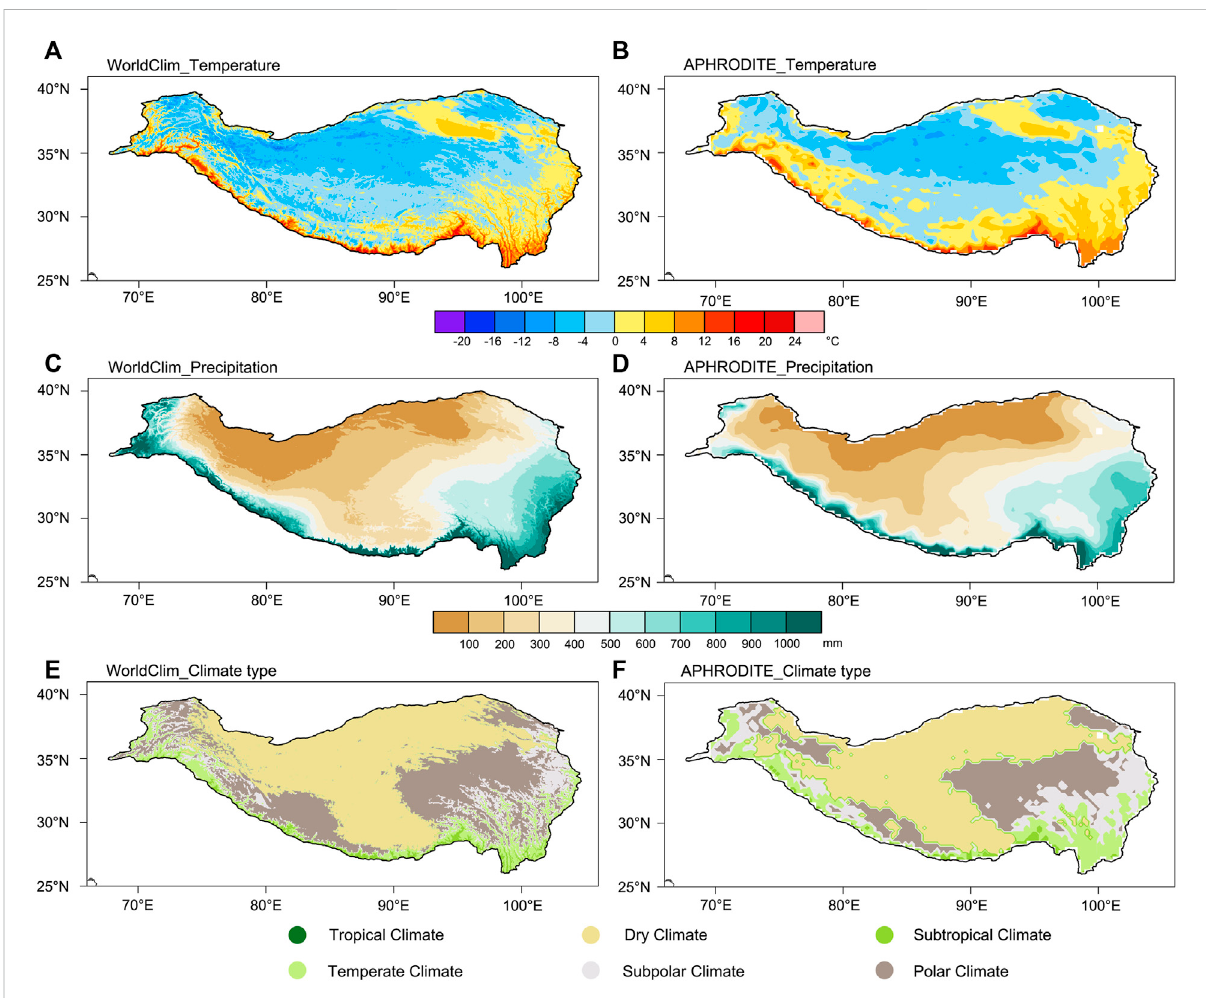
FIGURE 2 Distribution of temperature (A,B) (units: ° C), precipitation (C,D) (units: mm) and climate types (E,F) (detailed information in Table 1) across TP. (A,C,E) come from the WorldClim dataset, (B,D,F) come from the APHRODITE dataset. The periods of the plots are 1960 – 1990, except for the APHRODITE ’ s temperature in (B) is 1961 –